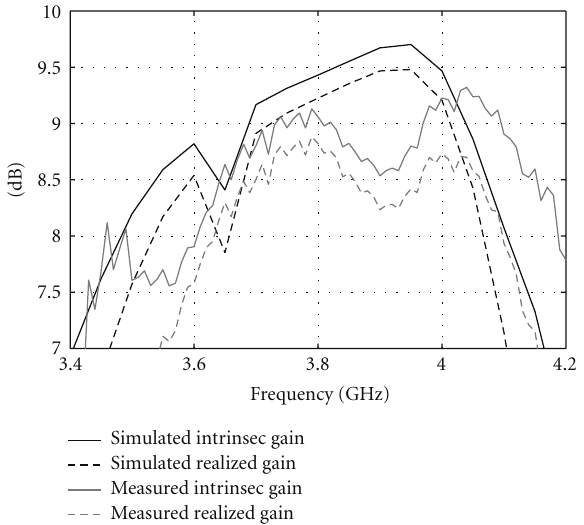
Figure 9: Comparison between simulated and measured radiation results.